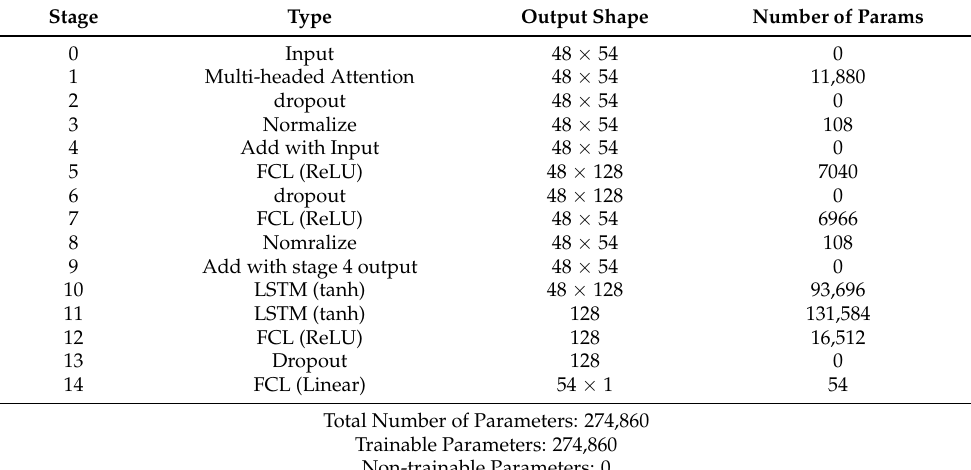
Table 3. Proposed FDI presence detection model